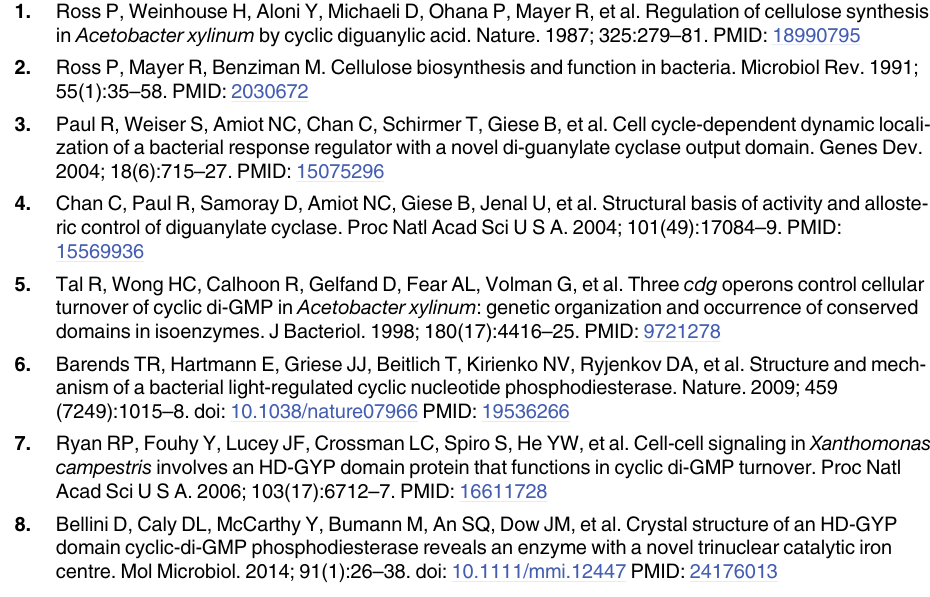
S4 Table. Primers used in this